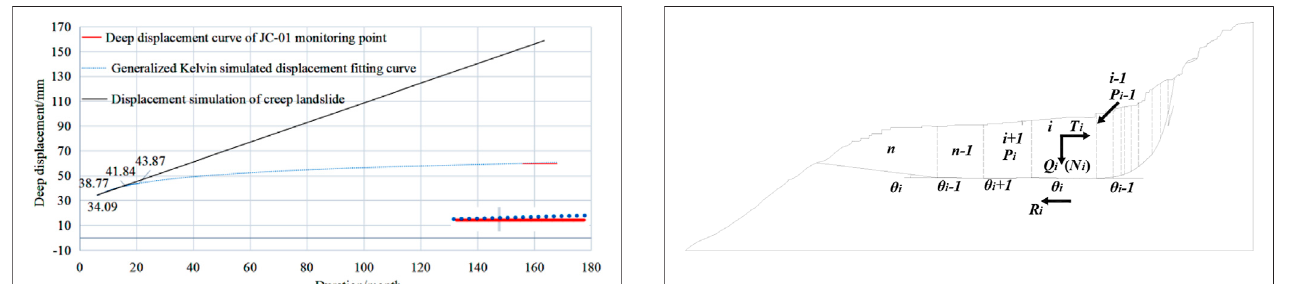
FIGURE 5 | Calculation diagram of transfer coef fi cient